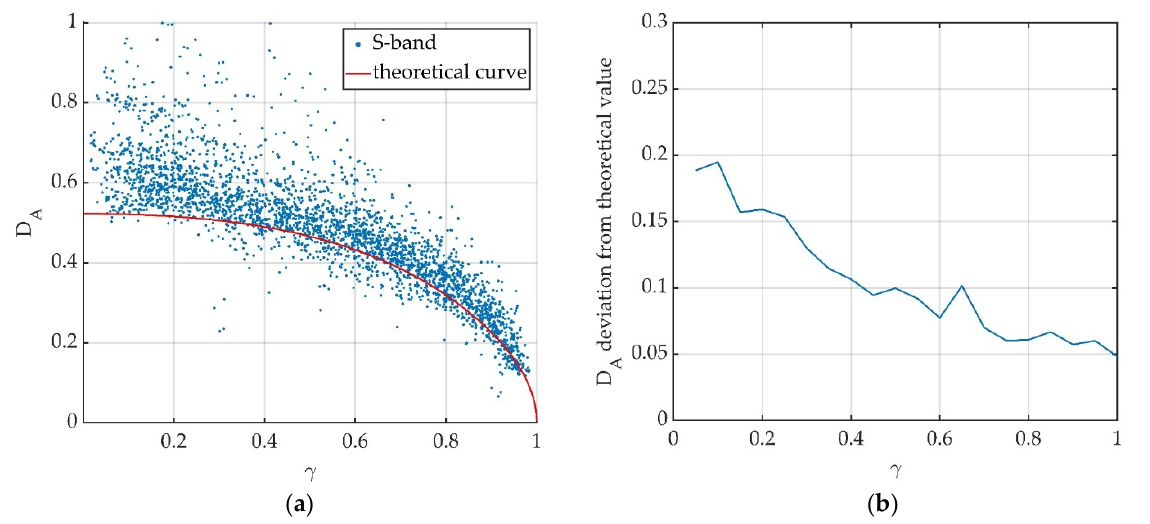
Figure 11. Results obtained for S-band data. ( a ) Values of D A as function of the coherence, calculated for resolution cells of the investigated area, in the urban scenario, in Florence. ( b ) Deviation of experimental D A values from theoretical ones.